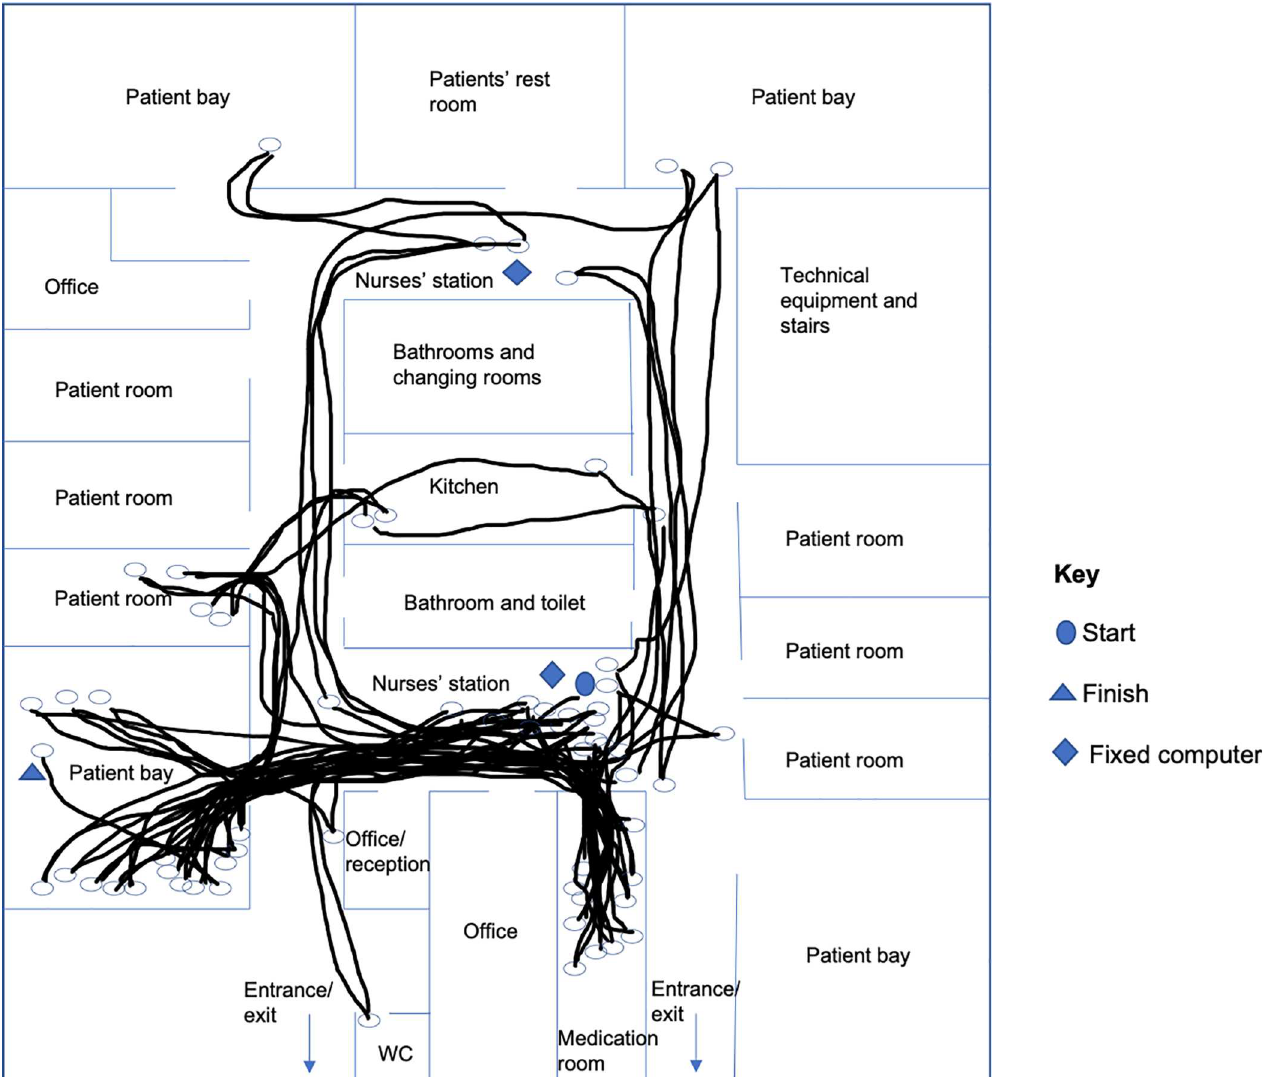
Fig 2. A spaghetti diagram showing nurse travel around ward B. Medication round duration: 120 minutes; number of patients who received medication: 4; number of doses administered: 26.